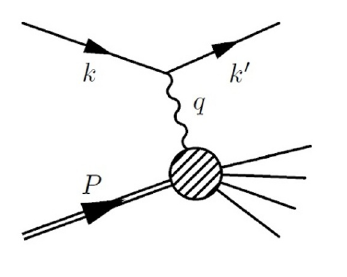
Figure 1 . Illustration of DIS. A charged lepton exchanges a virtual photon with a hadron of four-momentum P . The incoming and outgoing lepton four-momenta are k and k ′ ,